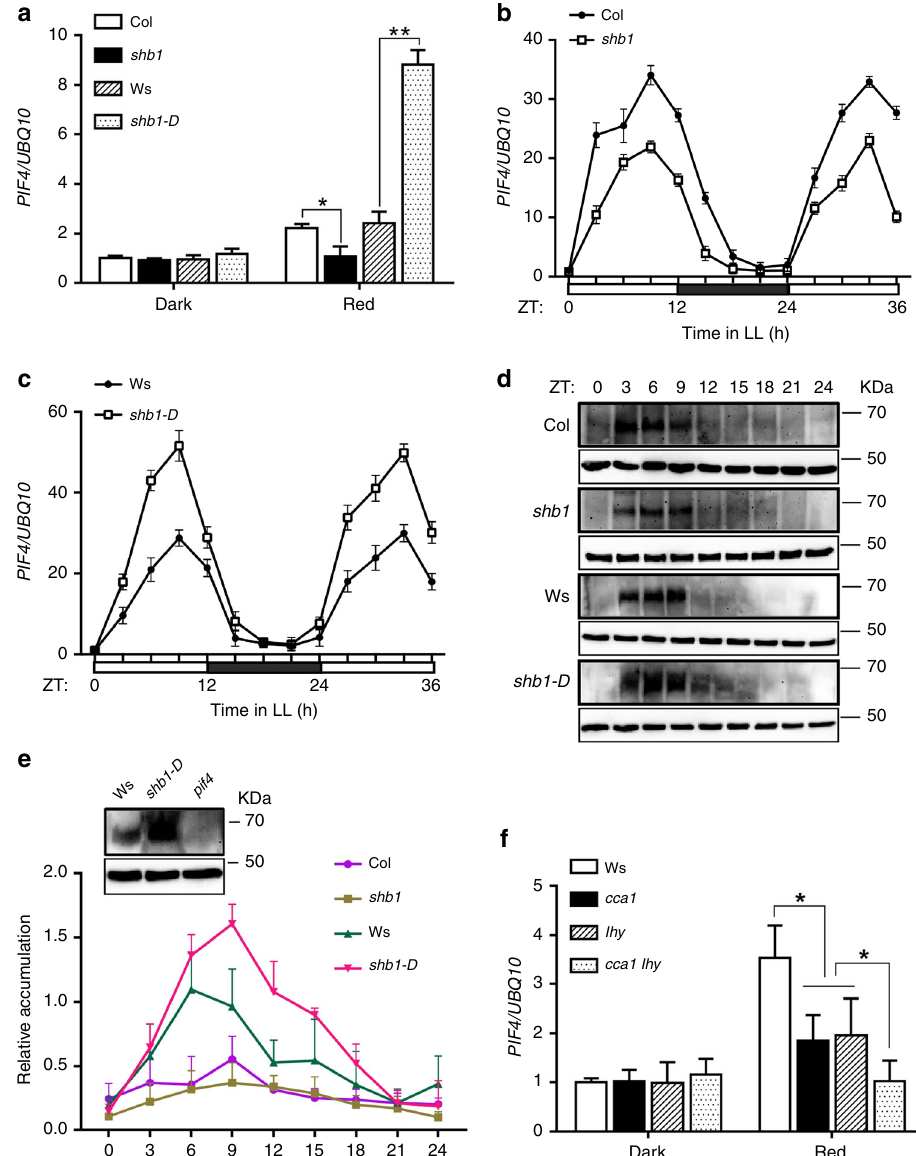
Fig. 1 SHB1 and CCA1/LHY regulate PIF4 expression under red light. a PIF4 expression in 4-day-old Col, shb1 , Ws, and shb1-D seedlings in the dark and under 15 μ mol m − 2 s − 1 red light for 3 hr. * and ** indicate signi fi cance levels p < 0.05 and p < 0.01, respectively. ns indicates not signi fi cant by Student ’ s two-tailed heteroscedastic t tests in this fi gure and subsequent fi gures. PIF4 expression in Col and shb1 b or Ws and shb1-D c under continuous red light after entrained under 12-hr light and 12-hr dark for 7 days from two biological replicates. d PIF4 protein accumulation in Col, shb1 , Ws, and shb1-D under 12- hr red light and 12-hr dark photoperiod, shown as representative images from three biological replicates. e PIF4 protein quanti fi cation normalized to actin with standard error bars. The control blot shows PIF4 accumulation in Ws, shb1-D and pif4 at ZT6. f PIF4 expression in Ws, cca1, lhy, and cca1 lhy in the dark and under 15 μ mol m − 2 s − 1 red light. Expression of PIF4 in each sample was normalized to that of UBQ10 , and data are presented as the means± SE. Source data are provided as a Source Data fi